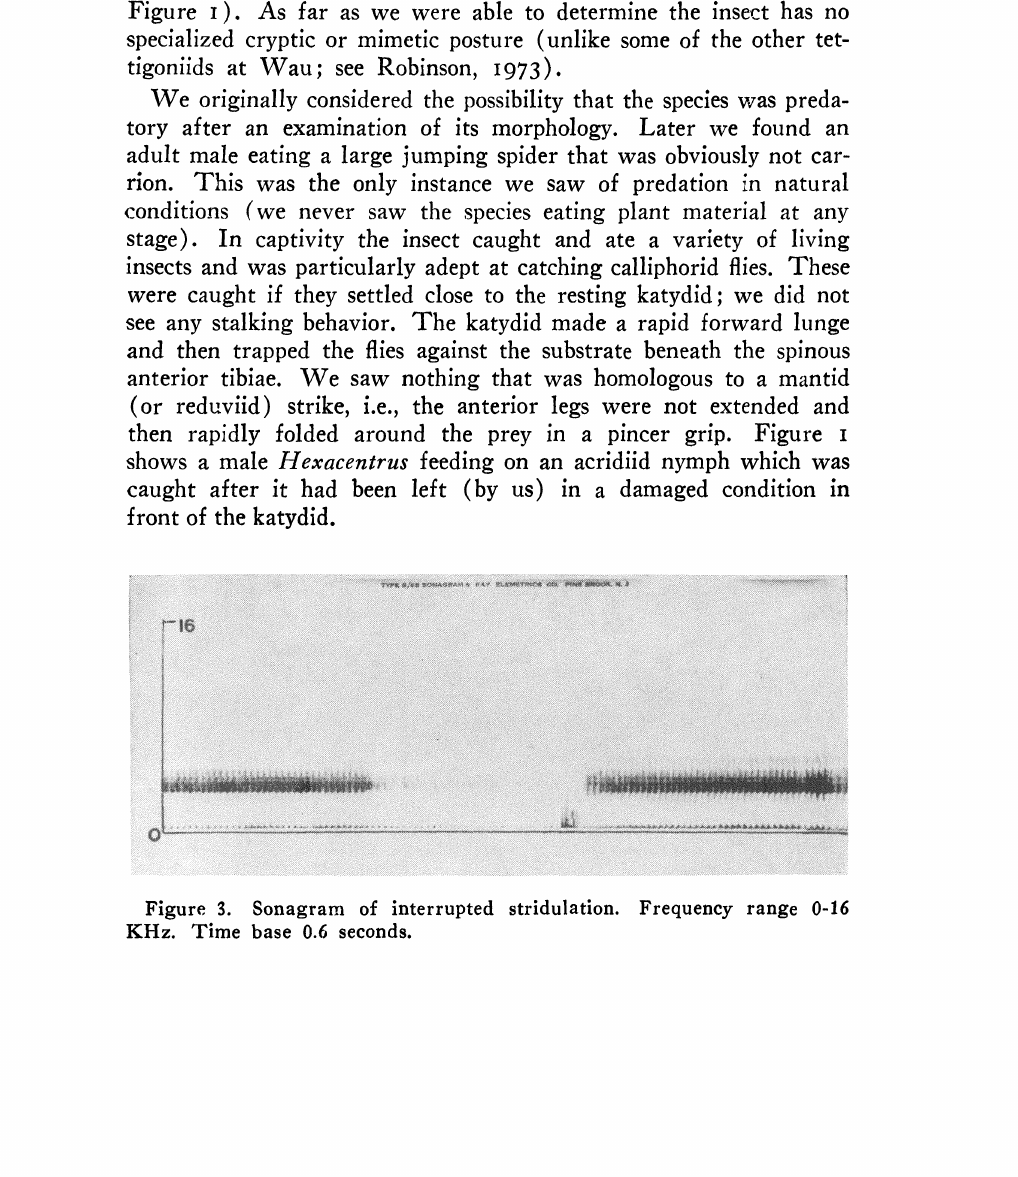
Figure 3. Sonagram of interrupted stridulation. Frequency range 0-16 KHz. Time base 0.6